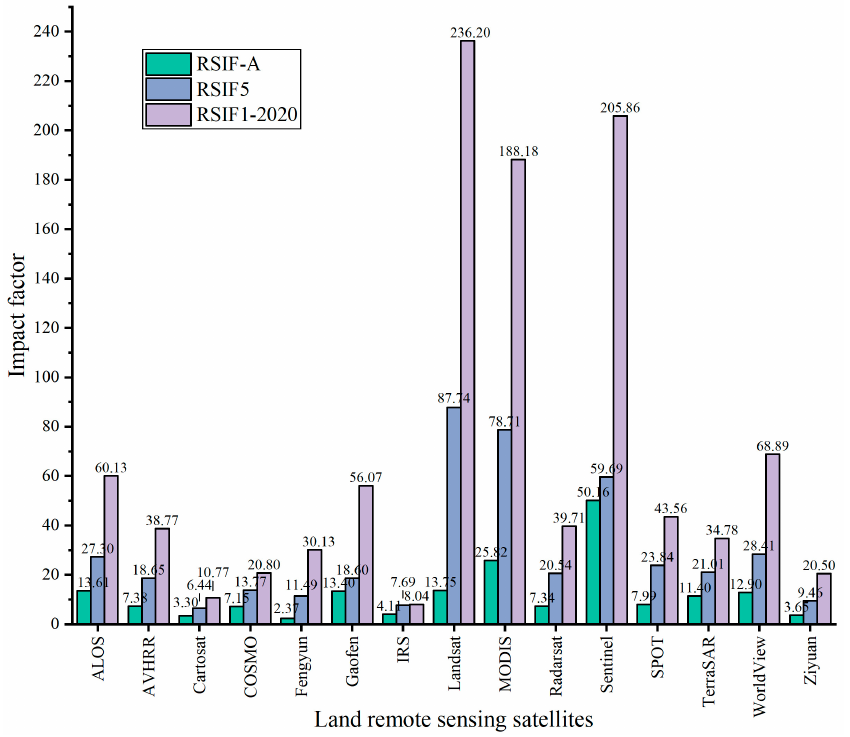
Figure 2. Derived RSIFs for Earth observation satellites.